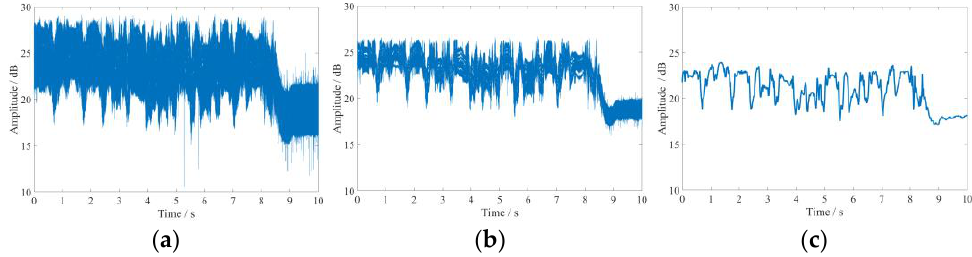
Figure 5. Motion data processing: ( a ) CSI raw motion data; ( b ) signal denoising; ( c ) subcarrier